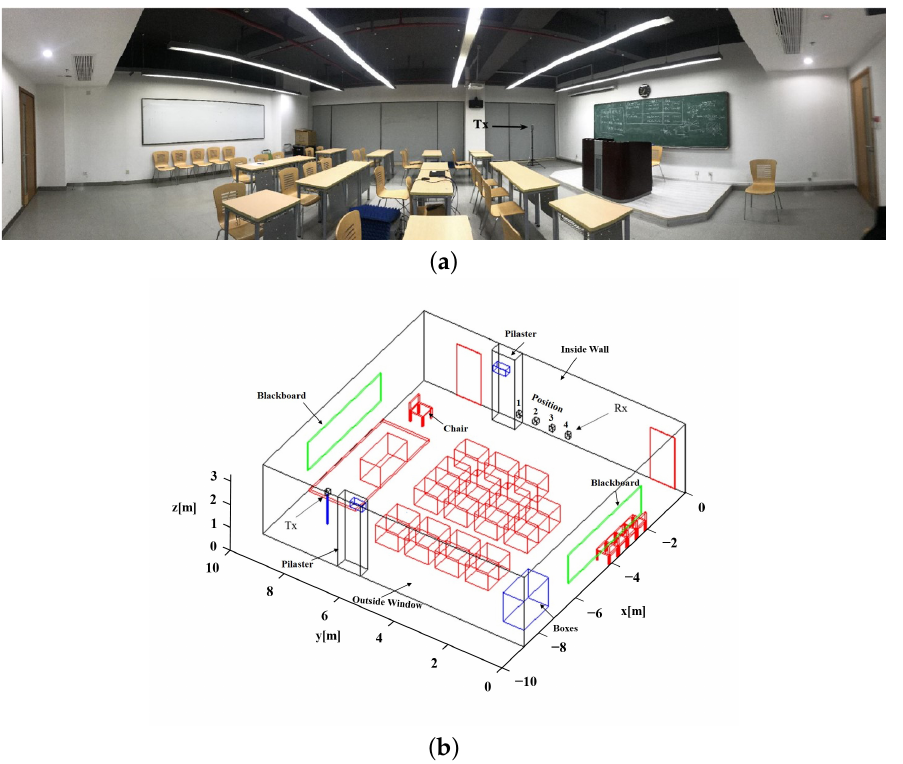
Figure 1. Real and digital pictures of the measurement scenario. ( a ) The photo taken at the view of Rx. ( b ) The 3D digital map of the indoor scenario.